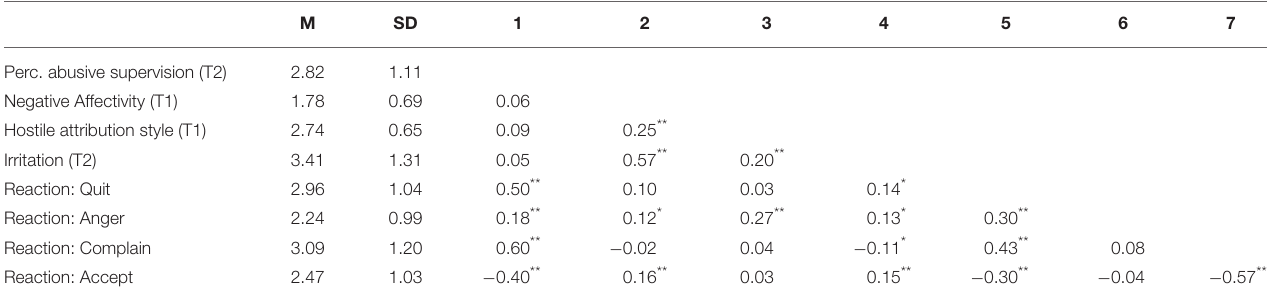
TABLE 3 | Intercorrelations for abusive supervision, control variables, and reactions (Study 1). M